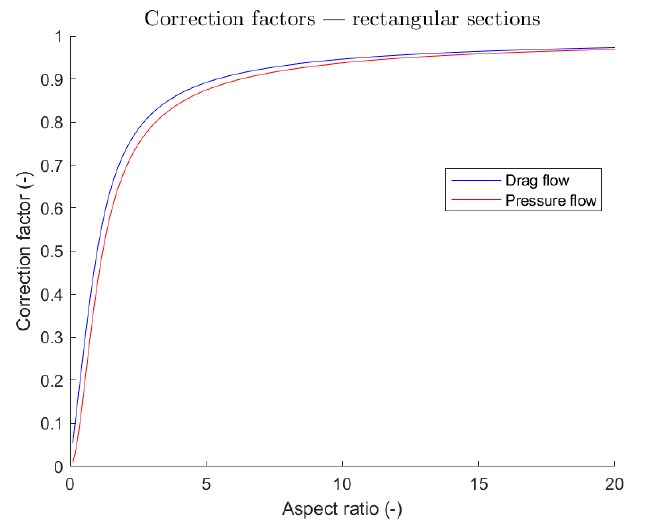
Figure 11. Correction factors for rectangular channels for a given aspect ratio (width to height ratio).